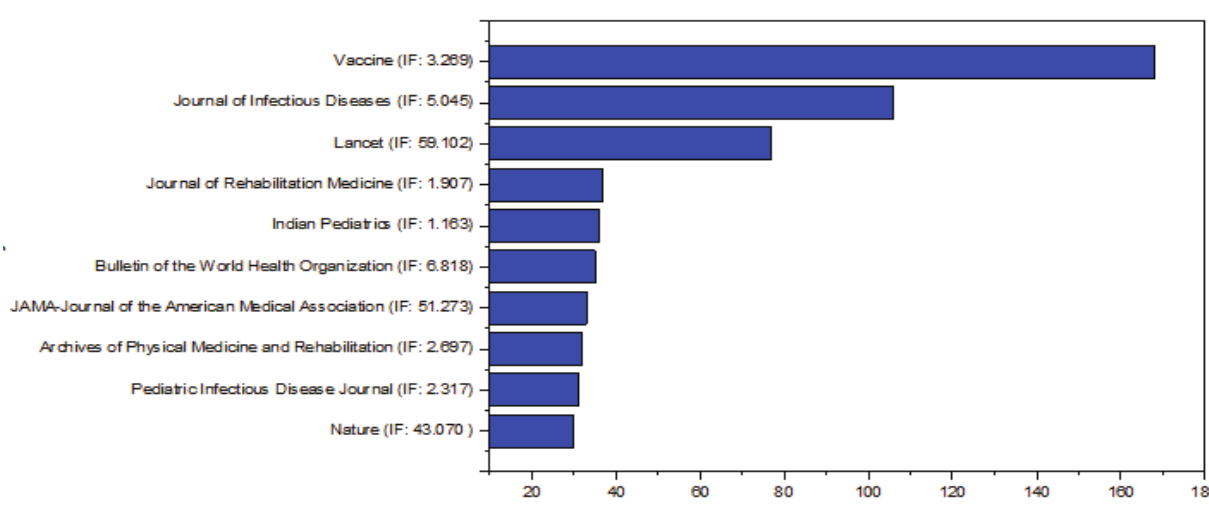
Figure-II: Top ten leading journals with the most number of publications. IF: Impact Factor.